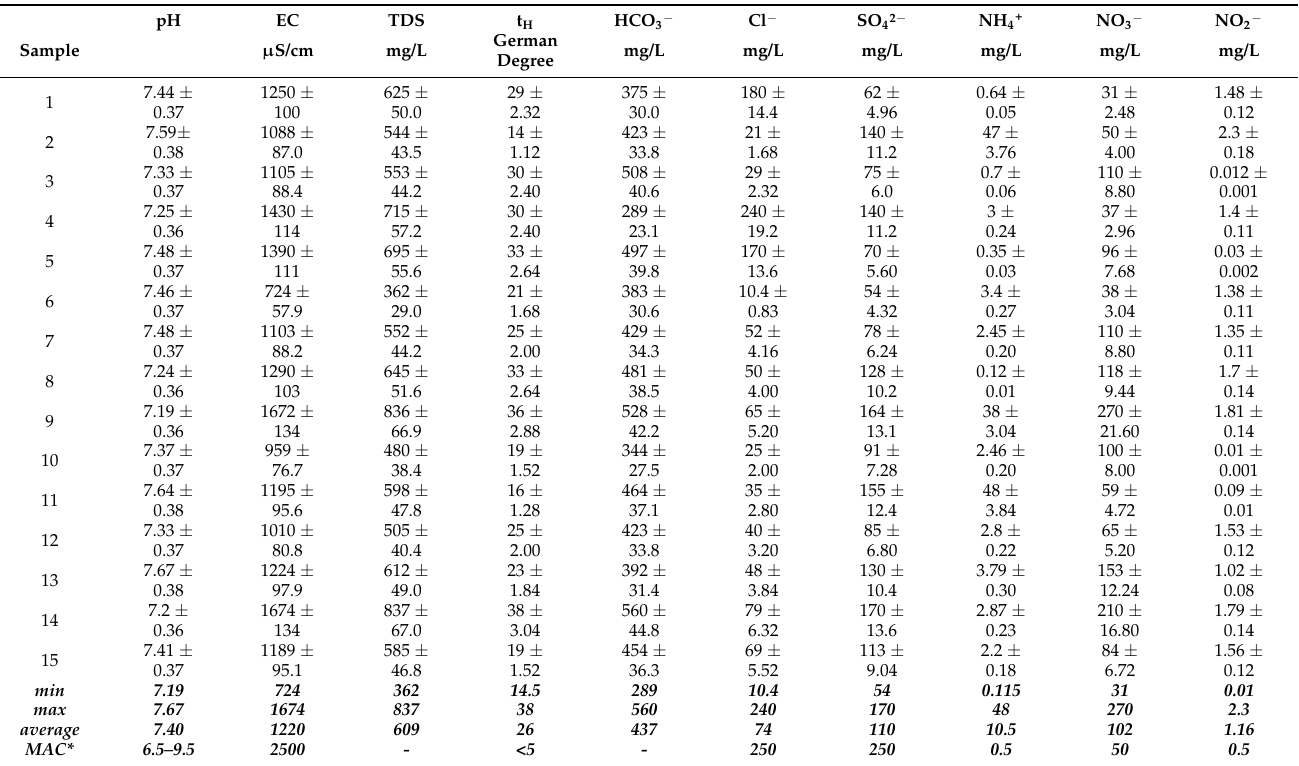
Figure 3. The principal component analysis (PCA) with total metal variables of the water samples in association with the sampling points. Table 1. Statistics of the mean concentrations of physico-chemical indicators in samples 1–15 (with the standard